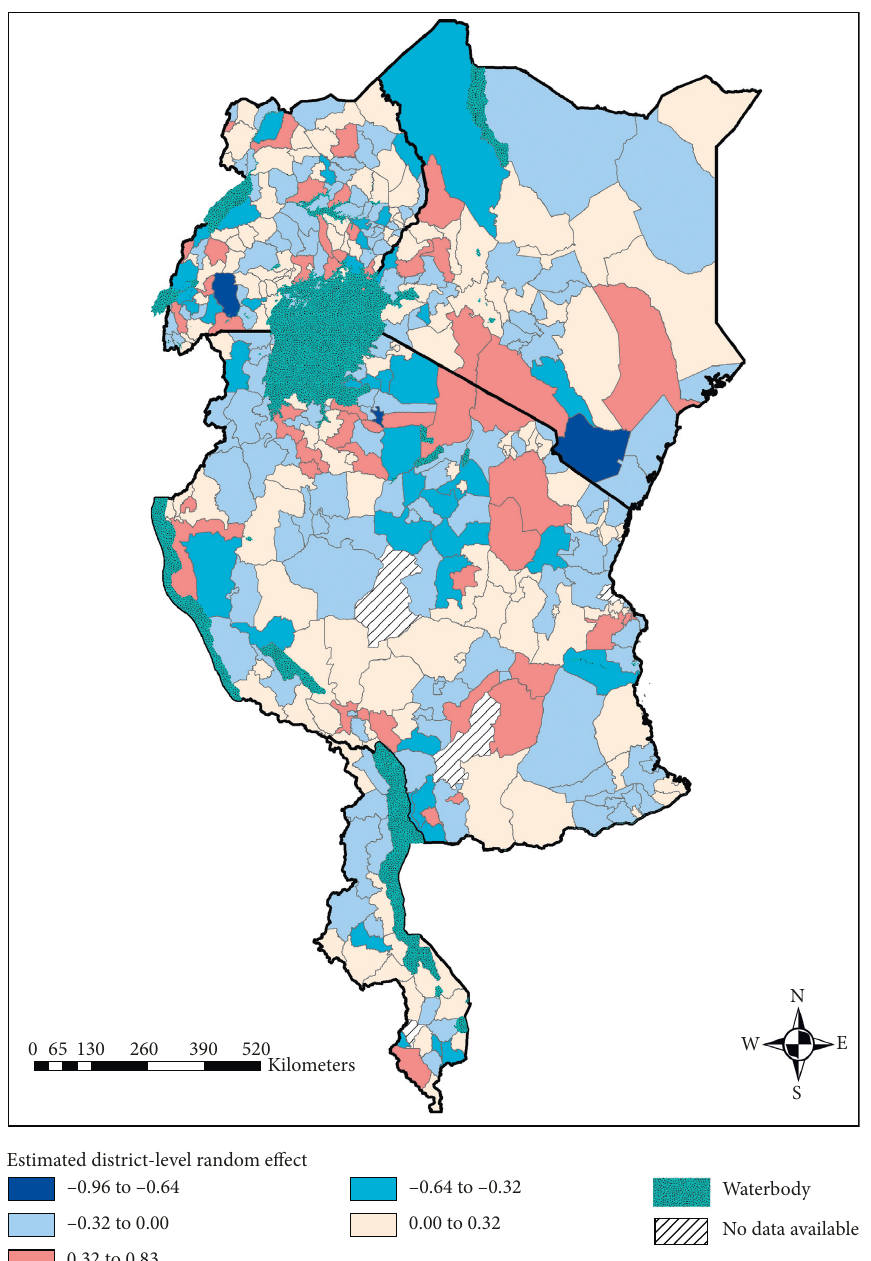
Figure 5: Estimated district-level random effect on the log-odds of anaemia (top left: Uganda; top right: Kenya; middle: Tanzania; bottom: